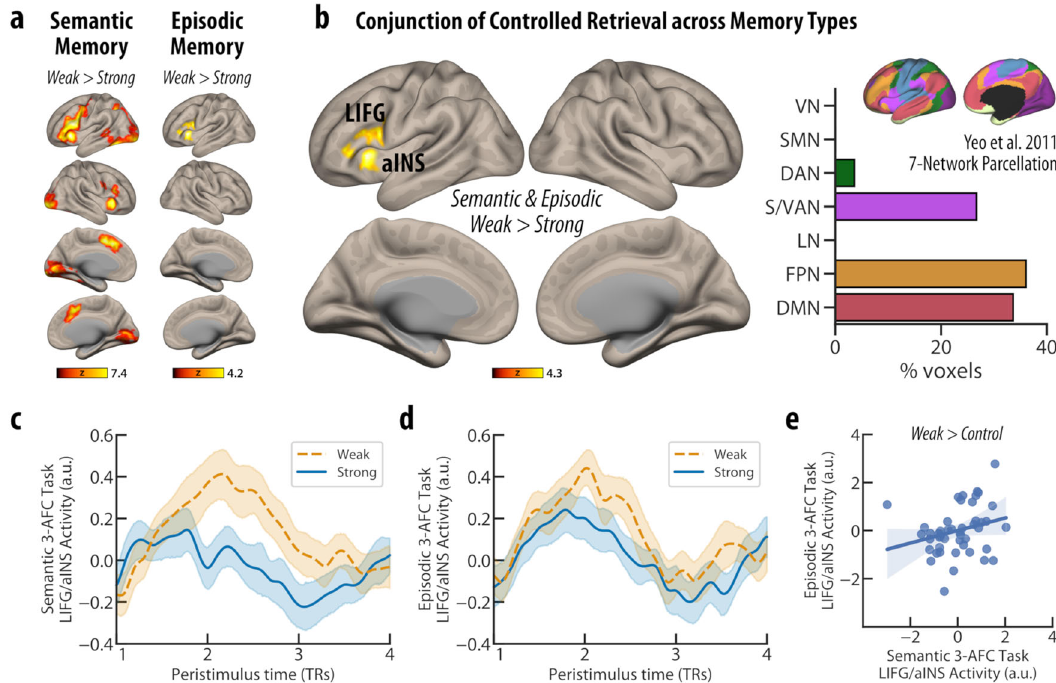
Fig. 3 Shared brain activity patterns associated with controlled retrieval across long-term memory types. a For both semantic and episodic 3-AFC fMRI tasks, shared neural responses were observed in the retrieval of weakly versus strongly associated word-pairs. b A formal conjunction analysis illustrated that for the weak > strong contrast, left inferior frontal gyrus (LIFG) and anterior insular cortex (aINS) showed greater activity for both memory types, which largely overlapped with the frontoparietal, salience/ventral attention, and default mode networks (based on the Yeo 7-Network parcellation 24 ) (VN = visual network, SMN = somatomotor network, DAN = dorsal attention network, S/VAN = salience/ventral attention network, LN = limbic network, FPN = frontoparietal network, DMN = default mode network). c , d The peristimulus time plots (for illustrative purposes only) showed sustained activity differences between weak versus strong trials (in comparison to implicit baseline) that spanned 1-3 repetition times (TRs) across all participants for both memory types. While curved lines represent the best fi t to a smoothing spline over mean activity values, shaded areas re fl ect 95% con fi dence intervals. e LIFG/aINS activity differences during weak versus control trials between semantic and episodic memory tasks were signi fi cantly correlated across participants (partial r p = .29, p = 0.036, correcting for age and gender). Straight-line represents the best fi t, while shaded areas illustrate 95% con fi dence intervals. No such correlation was observed for activity differences between strong versus control trials for this cluster of brain regions across the two memory types (partial r p = .11, p = .24, correcting for age and gender). Source data are provided as a Source Data fi